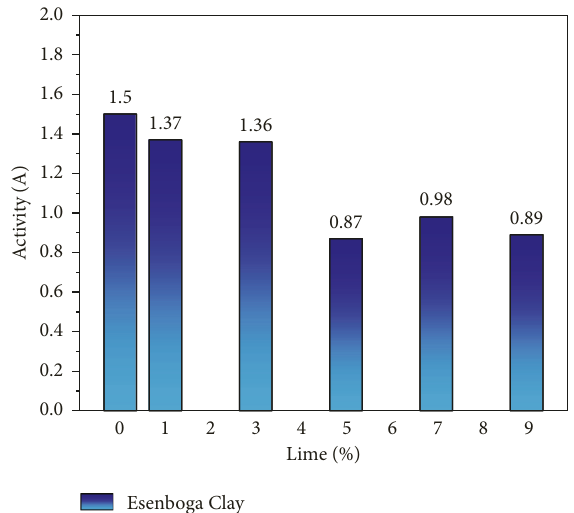
Figure 7: Variation in A (activity) with the lime content for Esenboga clay.